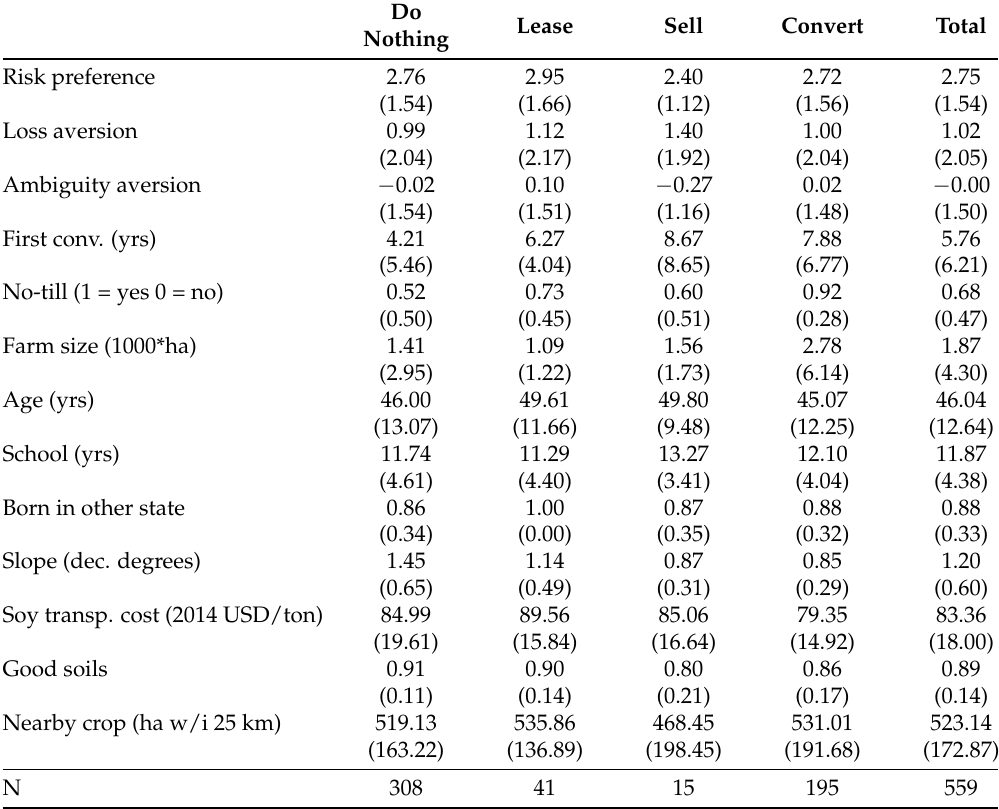
Table 1. Descriptive statistics by conversion